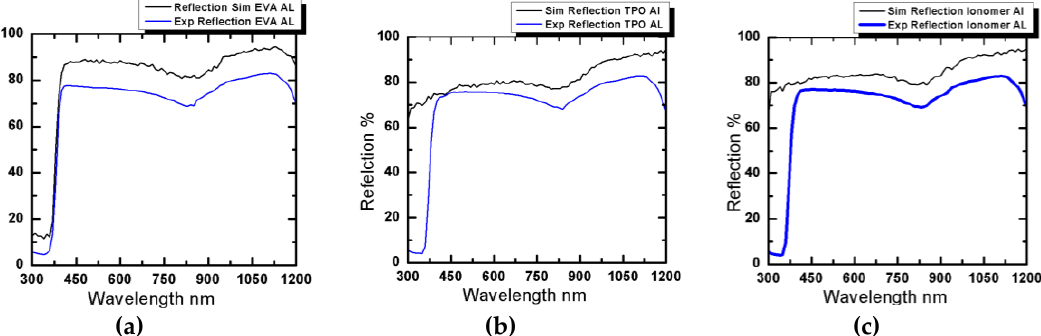
Figure 5. Reflection along the light spectrum using aluminum foil as back sheet for ( a ) EVA, ( b ) TPO, and ( c ) polybutadiene ionomer.